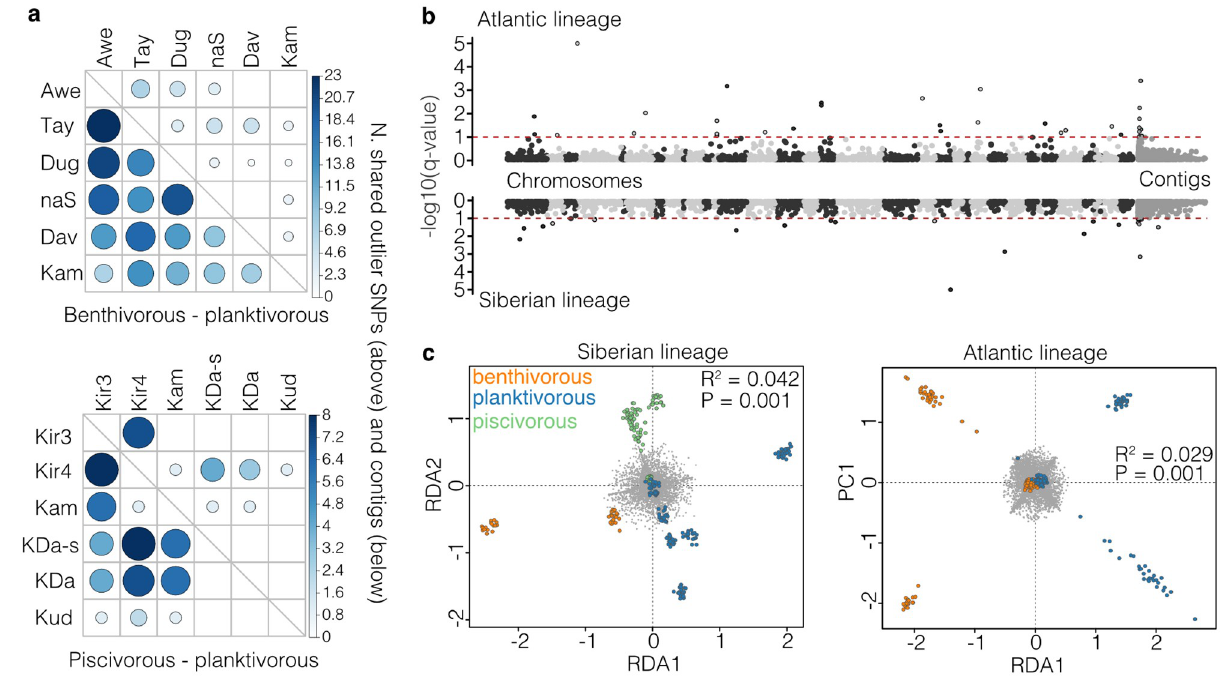
Fig 5. Non-parallelism in genetic differentiation and ecotype-association. ( A ) Sharing of outlier SNPs and contigs containing outlier SNPs across replicated benthivorous-planktivorous and piscivorous-planktivorous ecotype pairs. The colour and size of the dots illustrates the number of shared SNPs or contigs. None of the pairwise comparisons are significant based on permutation results (see Methods). ( B ) Manhattan plots showing the results of the hierarchical bayescan analysis. SNPs with -log10(q-values) above 1 (FDR < 0.1) show significant signs of parallel selection across ecotype pairs by lineage. The upper plot shows the results for benthivorous-planktivorous ecotype pairs in the Atlantic lineage, and the lower plot shows the results for piscivorous-planktivorous ecotype pairs in the Siberian lineage. Results for the benthivorous-planktivorous ecotype pairs from the Siberian lineage are shown in S10 Fig. Unplaced contigs are placed at the right end of the Manhattan plot. ( C ) Results of the redundancy analysis (RDA) for the Atlantic and Siberian lineages, showing varying levels of separation between ecotypes, coded by colour. The RDA significantly separates ecotypes after correcting for the effect of lake (results of ANOVA shown in plot). Grey dots show the loadings for individual SNPs. RDA1 is plotted against PC1 in the Atlantic lineage, as no second RDA is present based on the bimodal nature of the comparison. RDA1 also separated benthivorous and planktivorous ecotypes across lakes in the Siberian lineage, and RDA2 separated the piscivorous ecotype from both other ecotypes.